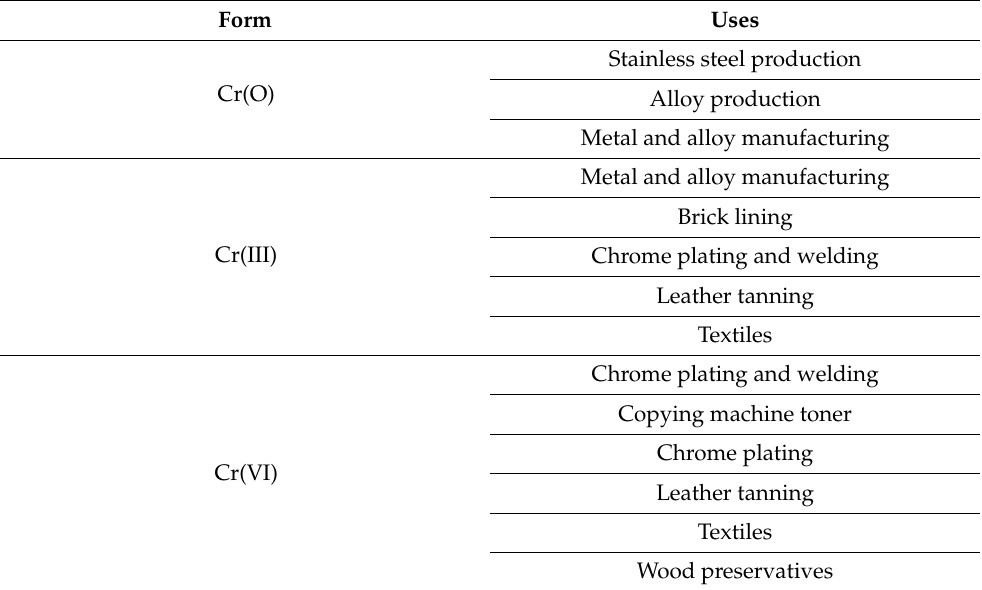
Table 2. Uses of